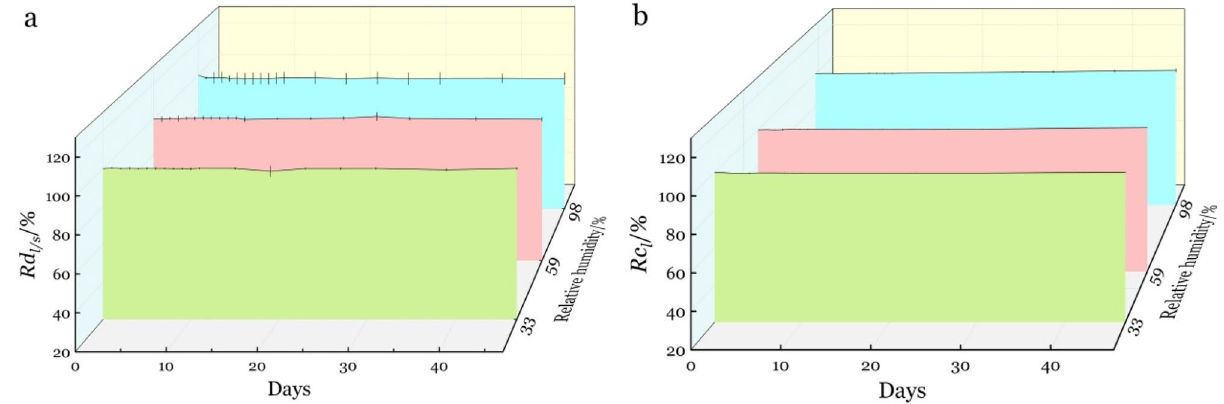
Figure 3. Changes in ratio with time for different relative humidity: ( a ) ratio of long diameter to short diameter ( Rd l/s ), and ( b ) chord length ( Rc l ).